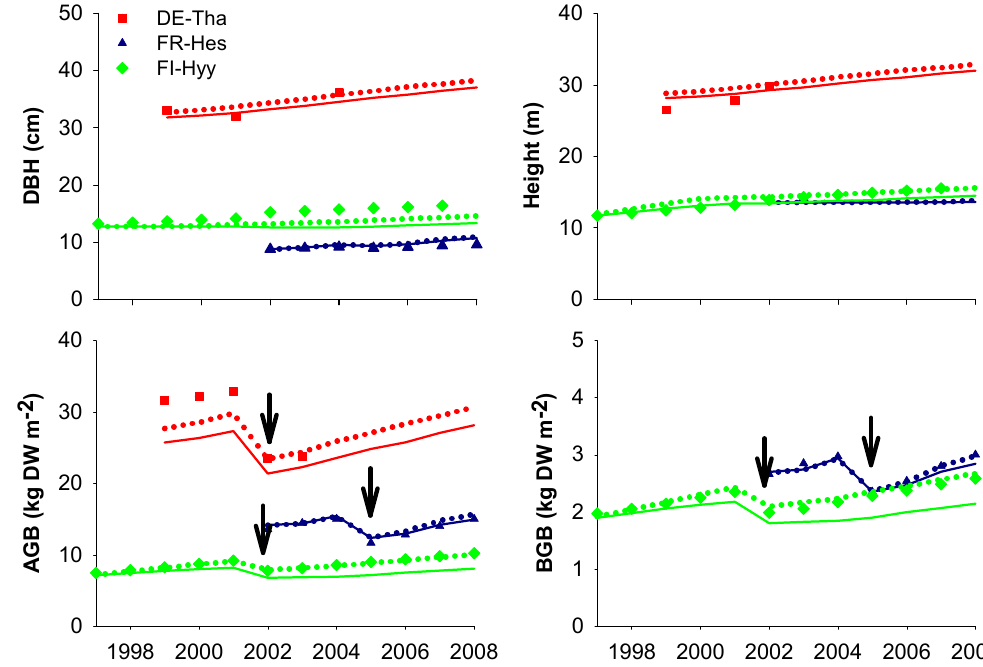
Figure 6. Measured and simulated forest development considering thinning events (indicated by arrows). Different colors indicate tree species: red squared/spruce (DE-Tha = Tharandt Germany), green diamond/pine (FI-Hyy = Hyytiälä Finland), and blue triangle/beech (FR-Hes = Hesse France). Measurements are represented by symbols and simulations by lines using dotted lines for simulations with site-specific parameters and straight lines for those with multi-site parameters. Abbreviations: AGB = aboveground biomass, BGB = belowground biomass, DBH = diameter at the breast